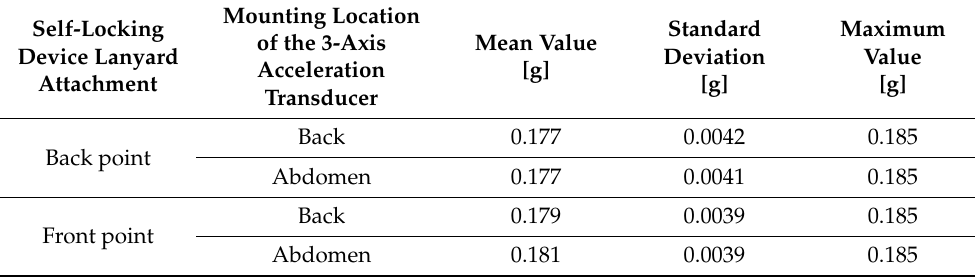
Figure 10. Acceleration as a function of time recorded during tipping. Test conditions: self-locking device at floor level; front point of the safety harness; the sensor mounted on the abdomen of the manikin. Table 1. Results of acceleration measurements when testing the behavior of the manikin during fall